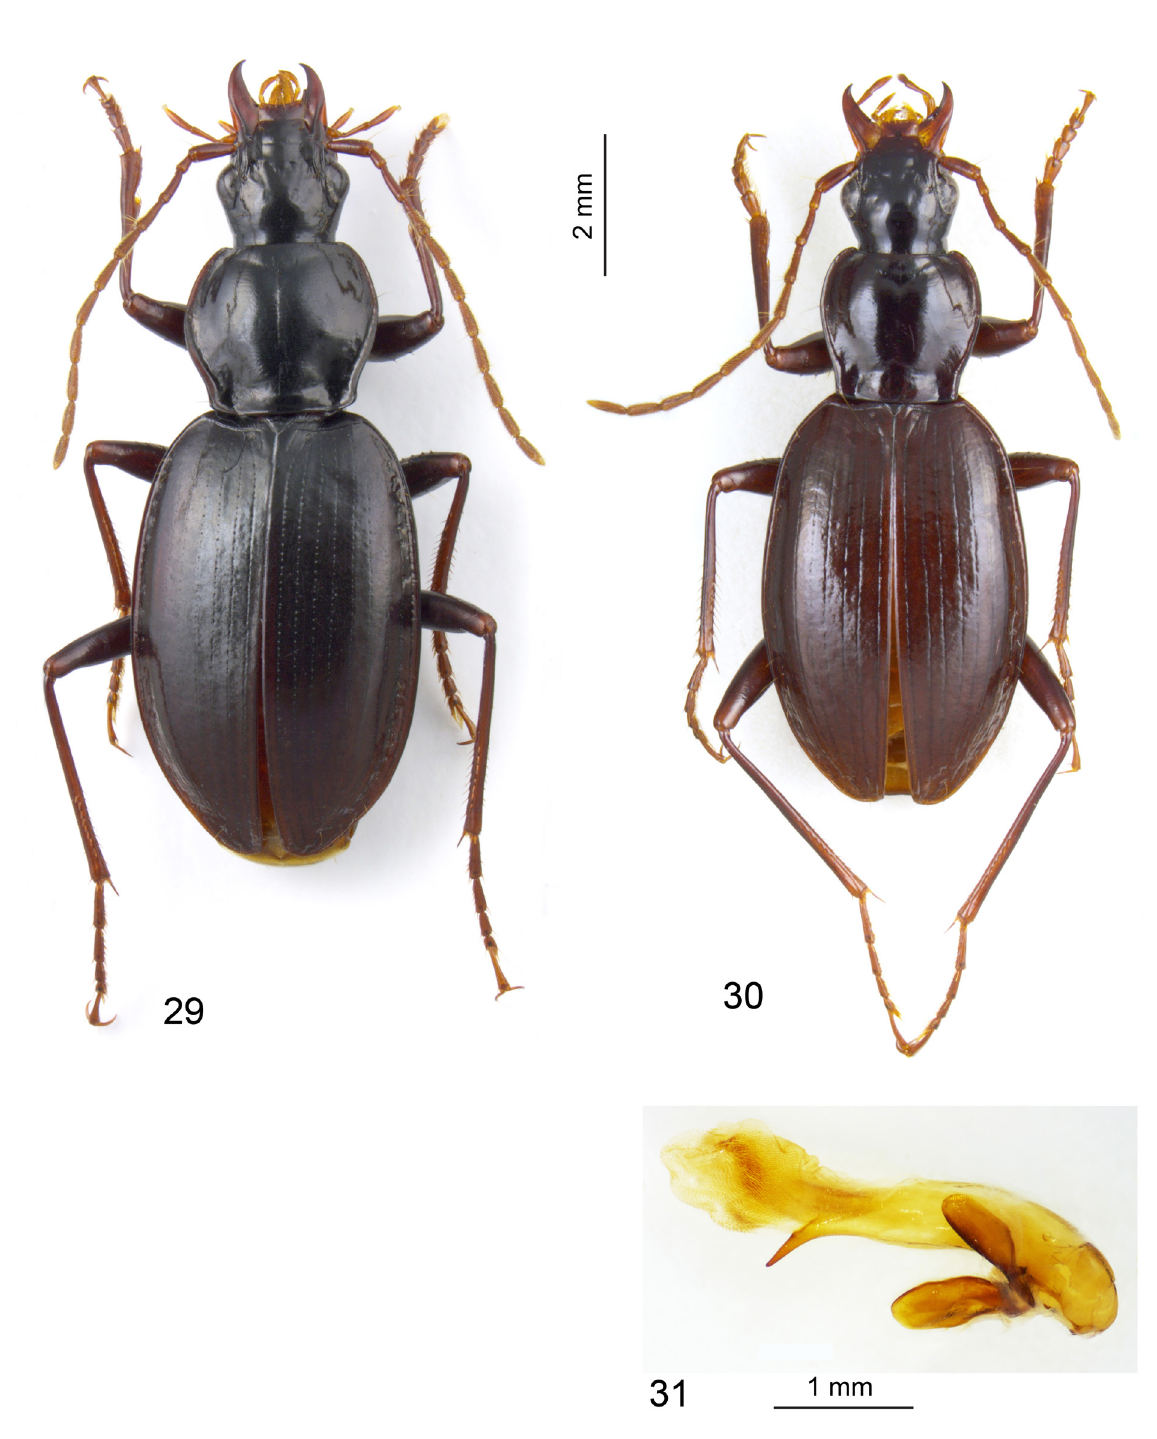
Figs 29–31. 29. Dyscolus crespoae Moret sp. nov., habitus of the female holotype (QACZ). 30– 31 . D. ravidus Moret sp. nov. 30 . Habitus of the male holotype (QACZ). 31 . Aedeagus, median lobe in lateral